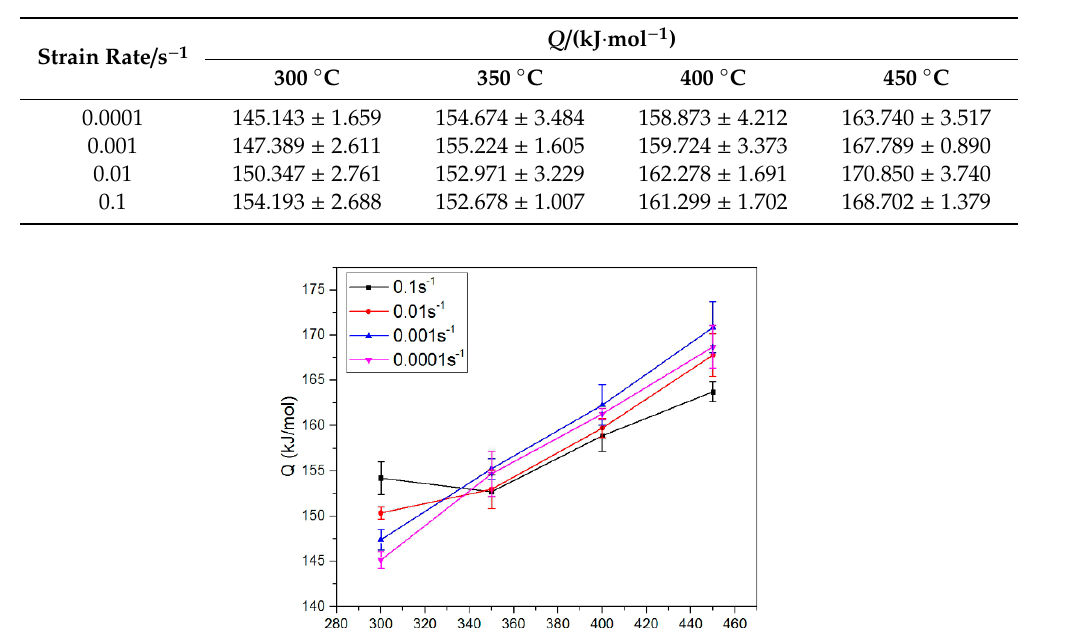
Table 2. Deformation activation energy of nanohybrid / AZ80 composite at di ff erent strain rates and deformation temperatures.